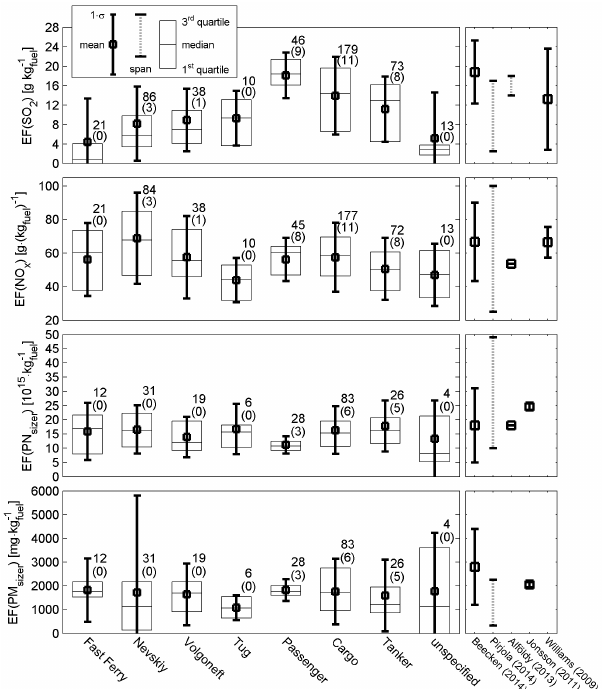
kg − 1 in 2011 fuel 2 Figure 5. SO 2 , NO x and particle emission factors over different ship types and comparison to results from the literature. The number close to the boxes denotes the number of sampled plumes from this ship type; numbers in brackets, the fraction of plumes that were measured from the helicopter. Ship types Nevsky, Volgoneft and Fast Ferry are shown separately from their main